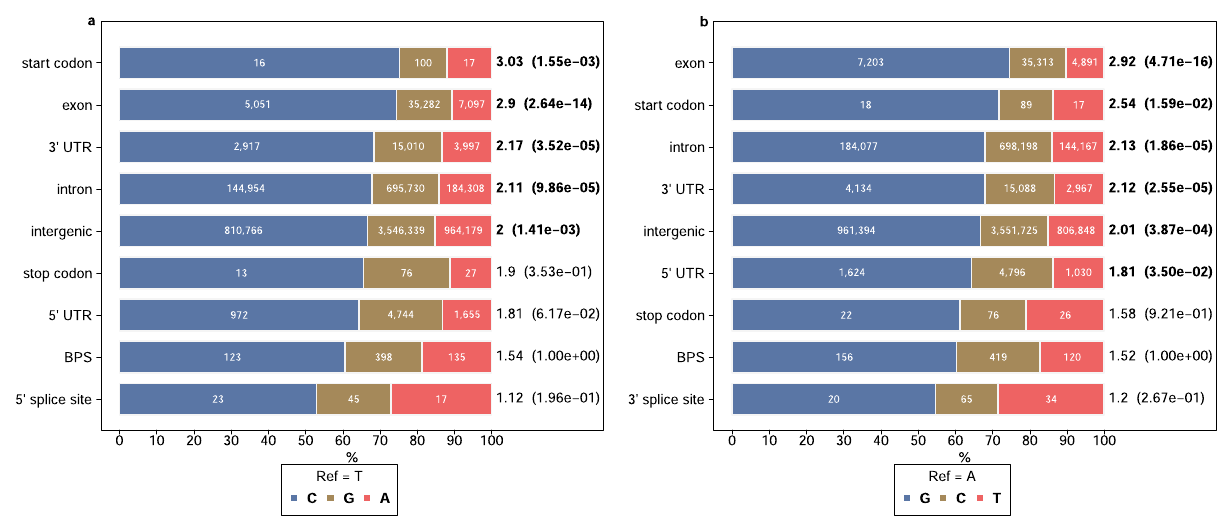
Fig. 5 Ti/Tv ratio of different genomic features. SNP mutation types of thymine at position 4 ( a ) and adenine at position 6 ( b ) within canonical ( “ TNA ” ) branch point sequence motifs and other genomic features. The widths of differently colored bars indicate the proportion of substitution to the other three nucleotides. The number of substitutions observed in our variant catalogue is given in the middle of each differently colored bar. The Ti/Tv ratio for the features is indicated at the end of the bars. Values in the parenthesis are p values (<0.05 indicated in bold text) from pairwise Fisher ’ s exact tests comparing the Ti/Tv ratio of nucleotides within the BPS and other genomic features. For splice sites, analysis was limited to a splice site where the canonical sequence motif (GT and AG at 5 ′ and 3 ′ splice sites respectively) contains the studied